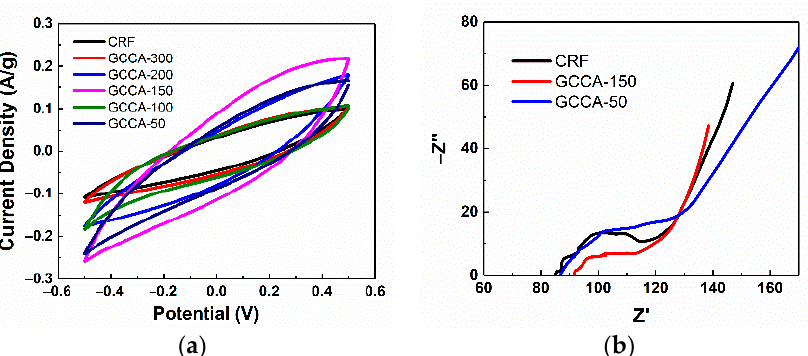
Figure 5. ( a ) Cyclic voltammograms and ( b ) electrochemical impedance spectroscopy results of the CRF and GCCA electrodes.